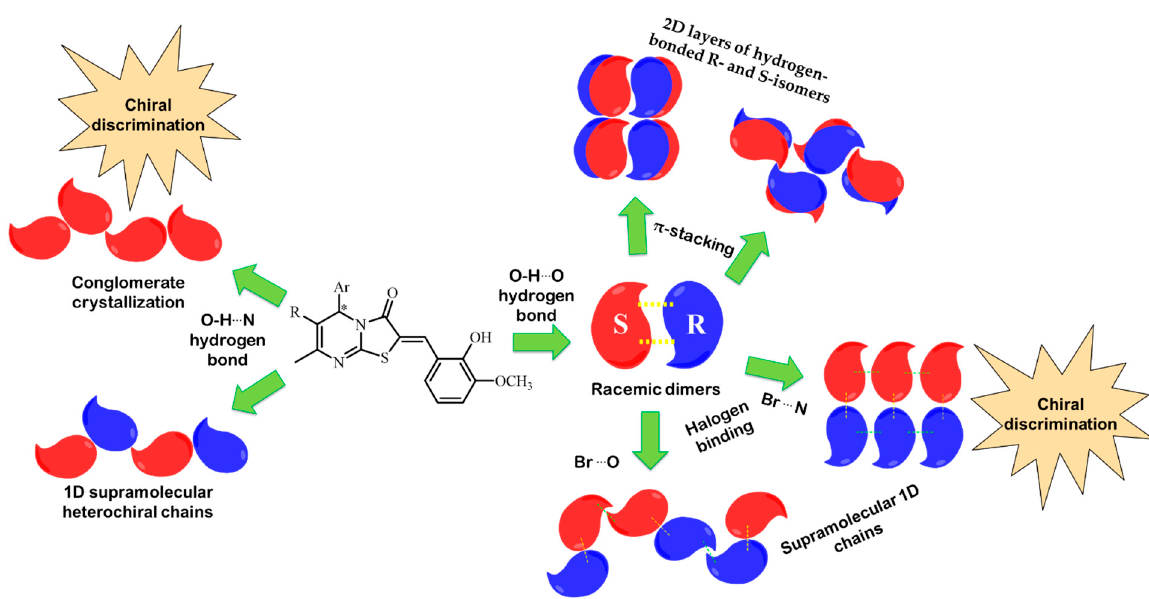
Figure 9. Generalizing scheme of the obtained crystal self-assemblies of synthesized compounds 1– 6. Red and blue represent the S- and R-isomers, respectively; yellow and green dotted lines represent hydrogen and halogen bonding, respectively.